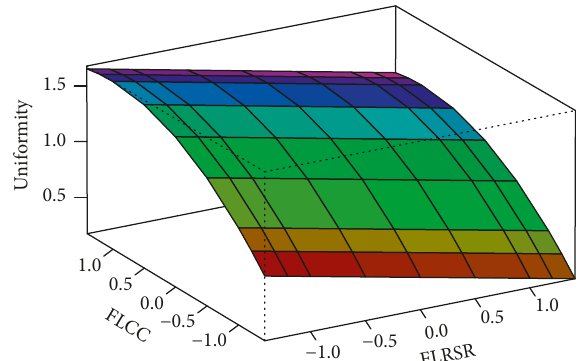
Figure 6: Schematic diagram of uniformity.